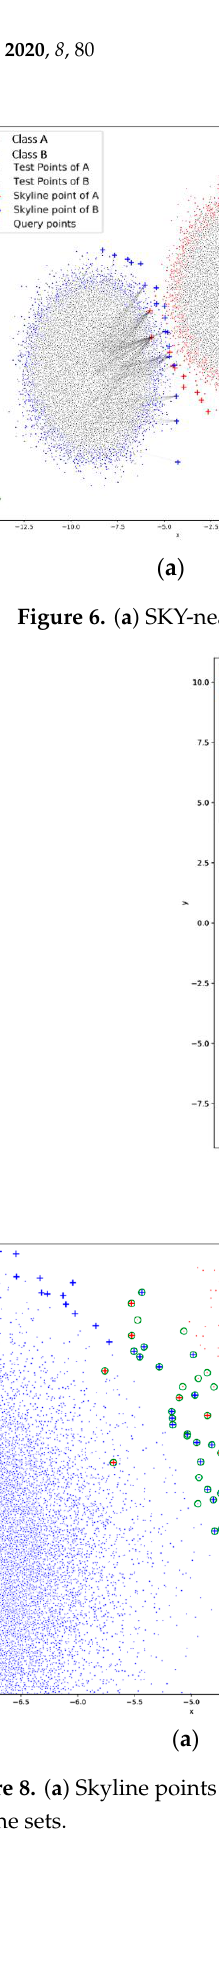
( b ) Figure 5. ( a ) Convex dataset; ( b ) banana dataset. 4.3. Decision Boundary Construction The boundary construction process uses the skyline points retrieved in the previous step and uses them to estimate the decision boundaries. The construction process is based on four different approaches as presented below. 1.